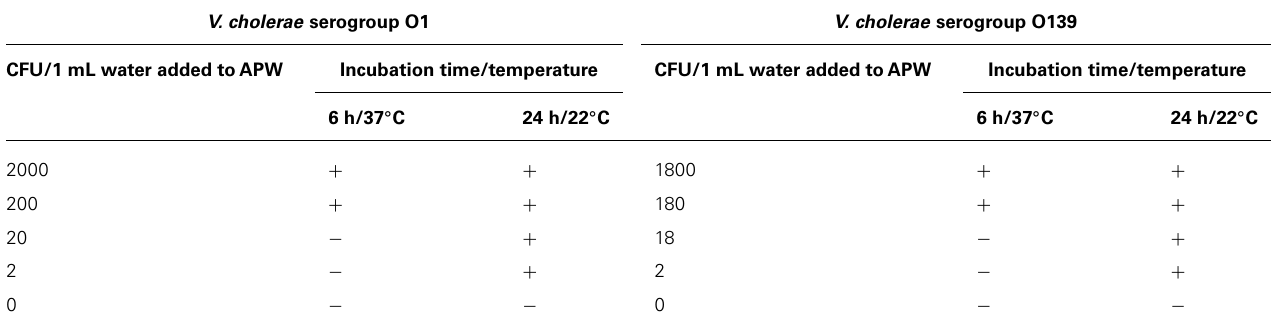
Table 1 | Dipstick detection of Vibrio cholerae -containing water samples incubated in alkaline peptone water